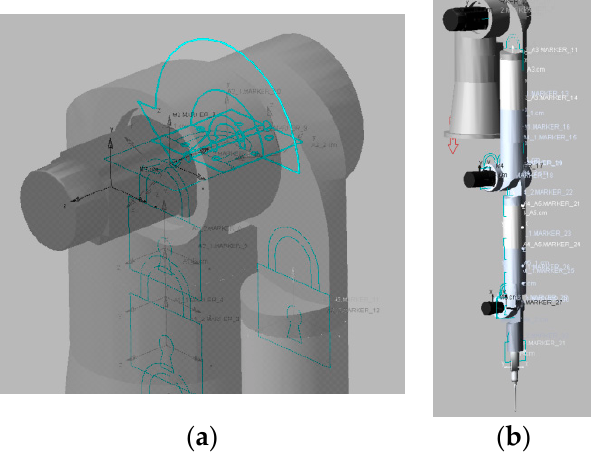
Figure 6. Simulation model for the self-driven AACMM, they should be listed as: ( a ) Description of what is Constraints and motion of Joint 2, ( b ) Description of what is initial pose.